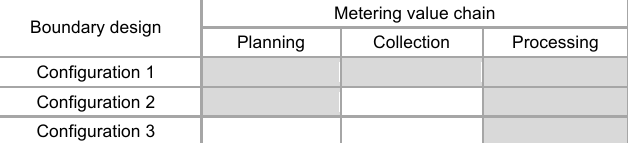
Boundary configurations of MRS along metering value chain Metering value chain Boundary design Planning Collection Processing